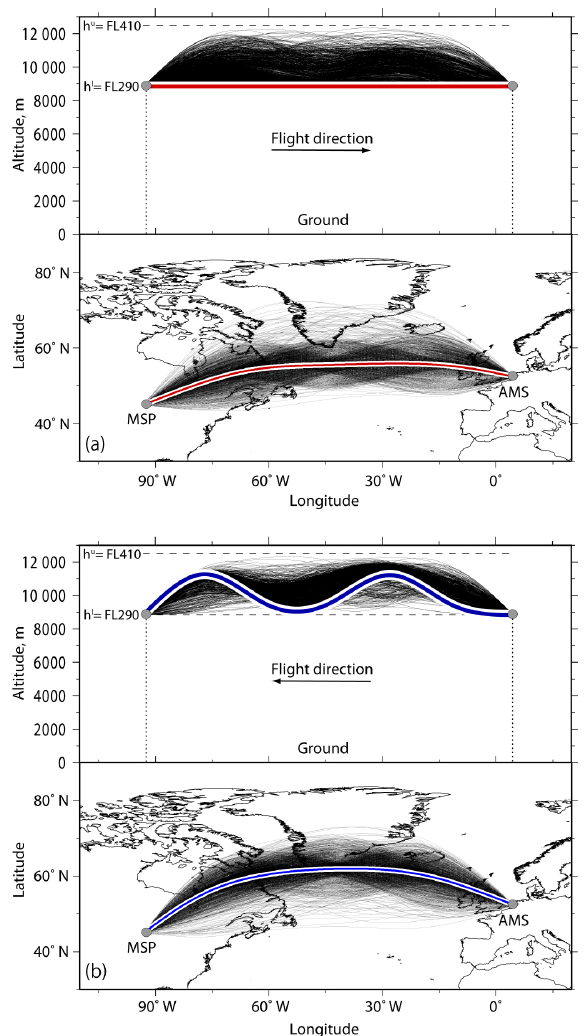
Figure 13. Ten-thousand explored trajectories (black lines) between MSP and AMS in the vertical cross section (top) and projection on the Earth (bottom), including the time-optimal flight trajectories (red and blue lines). (a) The eastbound flight from MSP to AMS. (b) The westbound flight from AMS to MSP.